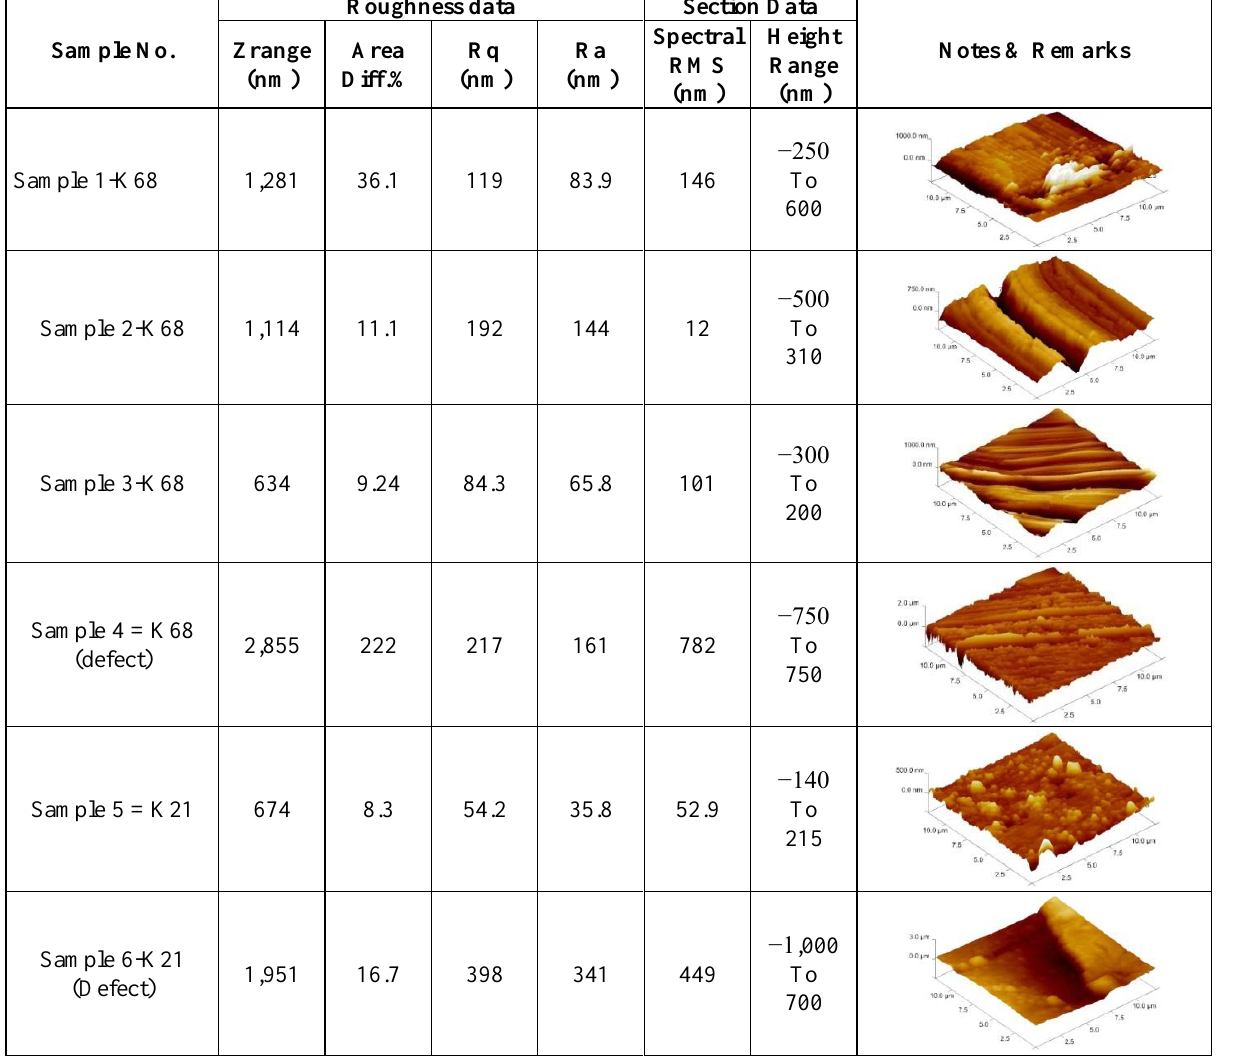
Table 2. Recommended surface controlling parameters for uncoated carbide inserts. Sample No.